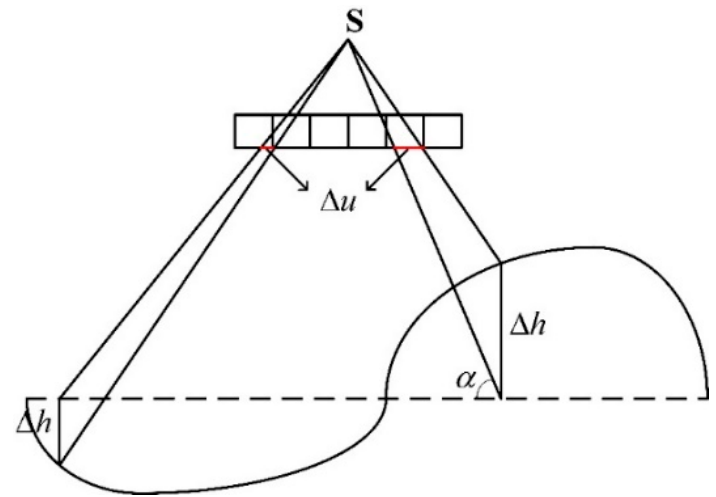
Figure 8. Effect of topographic relief of optical satellite images. ∆ u is the projection difference, α is the imaging altitude angle, ∆ h is the elevation difference between the ground point and height data.